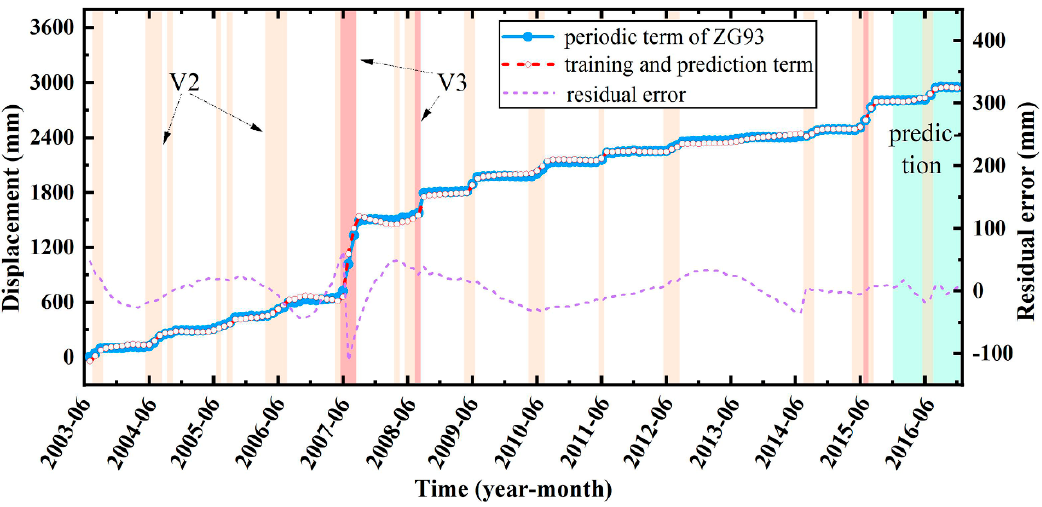
Figure 16. Training and prediction curves of the total displacement.